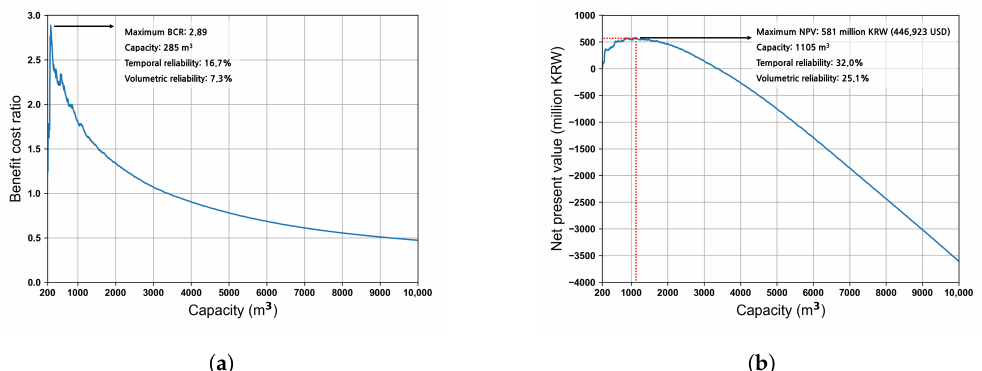
Figure 7. The results of the cost–benefit analysis for the capacity of the considered rainwater harvest- ing system: ( a ) the capacity–BCR curve; ( b ) the capacity–NPV